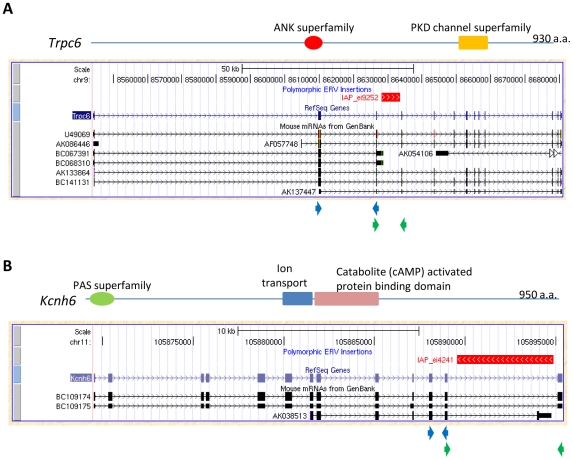
Chimeric transcripts of the Trpc6 gene and Kcnh6 gene in mice.Snapshots of the Trpc6 gene (A) and Kcnh6 gene (B) in UCSC Genome Browser are shown, with protein domains indicated. The red bar above the RefSeq gene annotation track shows the polymorphic LTR element insertion in B6 mice. For each gene, the mRNA track is shown, including the mRNAs terminating in the LTR element. Positions of primer sets used in the qRT-PCR experiments are indicated as arrowheads below the snapshot for each gene, with the upper pair (blue) for primers upstream of the polymorphic LTR element insertion, and the lower pair (green) for primers flanking the position of the LTR element insertion.